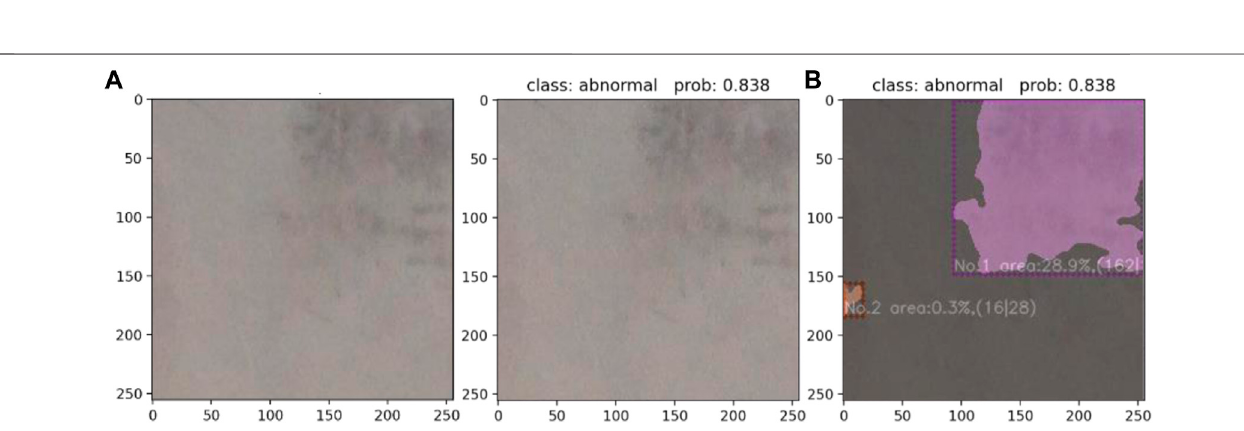
Frontiers in Materials |